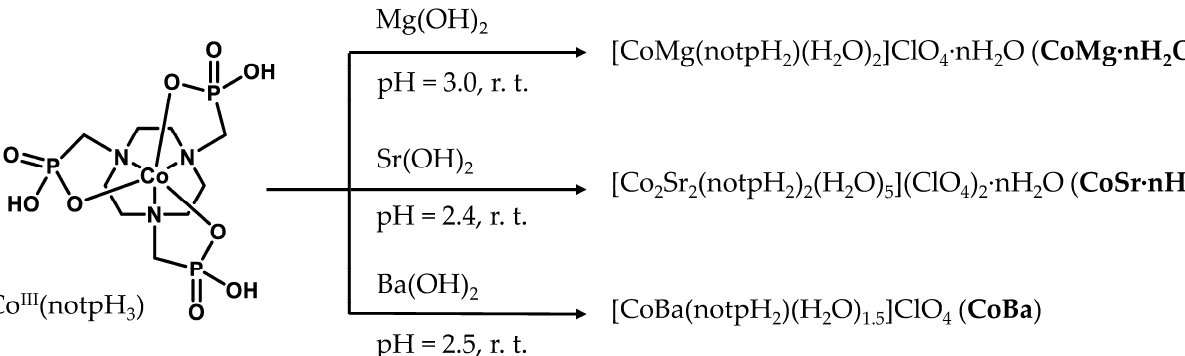
Figure 1. Synthesis of compounds CoMg·nH 2 O, CoSr·nH 2 O, and CoBa.